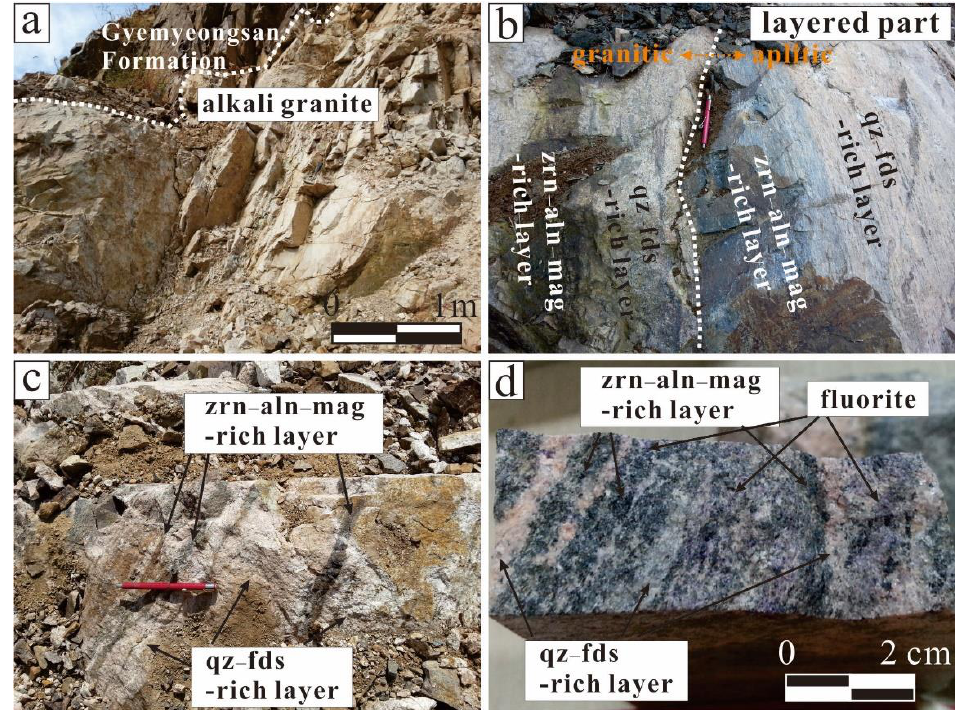
Figure 2. Layered alkali rocks. ( a ) The alkali granite intruded into the Gyemyeongsan Formation. ( b ) The quartz–feldspar (qz–fds)-rich layer and zircon–allanite–magnetite (zrn–aln–mag)-rich layer of the layered granite have a gradational relationship with the layered aplite. Pencil magnet: 12.5 cm. ( c ) Discontinuous and fragmented quartz–feldspar-rich and zircon–allanite–magnetite-rich layers. Pencil magnet: 12.5 cm. ( d ) Fluorite-rich (more than 1%) aggregate occur in the layered granite.